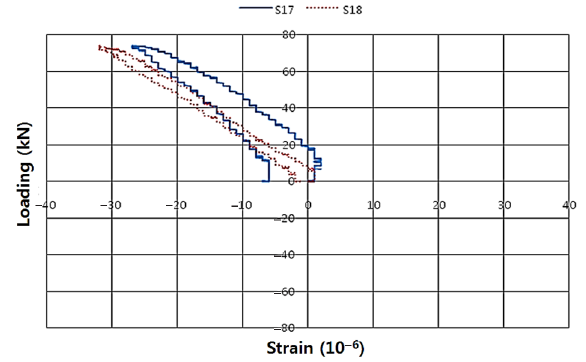
Fig. 16. Strain curves of concrete in the protruding part under an eccentric load of 73